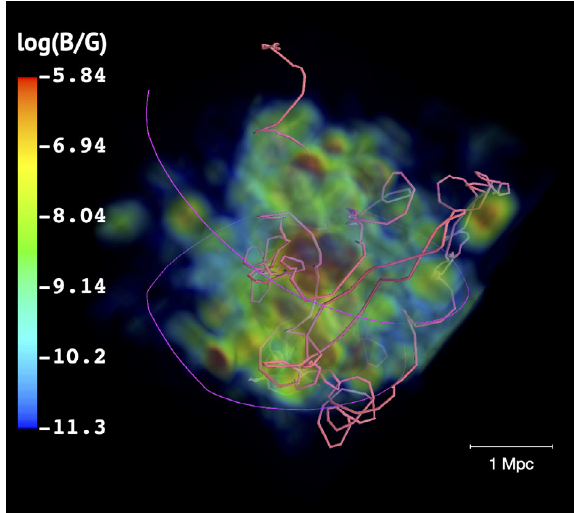
Fig.1| TrajectoriesofCRsthroughaclusterofmass~10 15 M ⊙ selectedfromour backgroundsimulation. Themapdepictsthemagnetic fi eldintensitydistribution in the cluster. The thick (pink) line corresponds to a CR with energy of 10PeV,and the thin (purple) line to a CR with energy 500PeV.